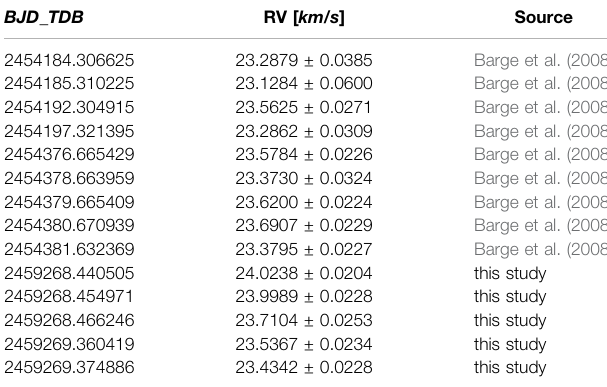
TABLE 4 | RV observations of